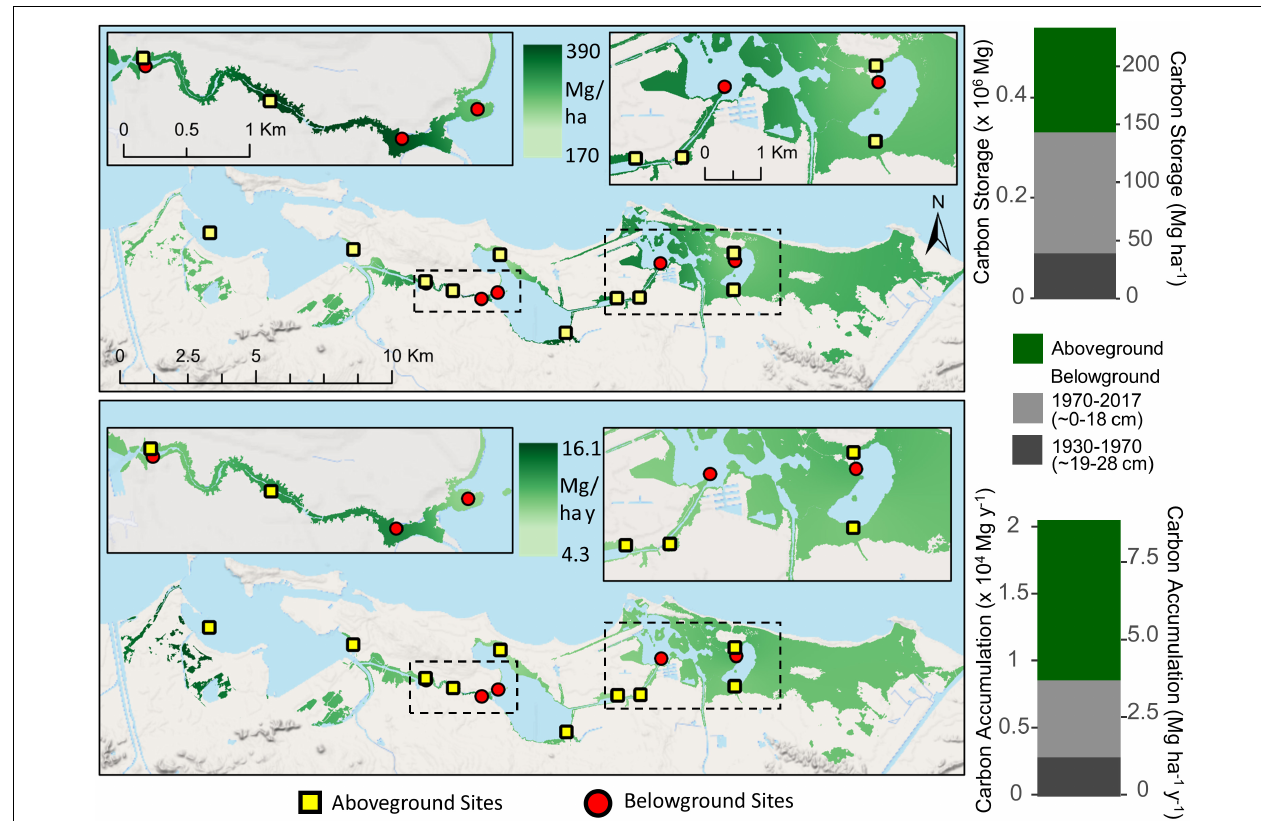
FIGURE 5 | Interpolated mangrove forest carbon storage (top) and accumulation rates (bottom) for both aboveground and belowground soil ( < 28 cm) components in the San Juan Bay Estuary. Map values represent distance weighted interpolations between known measurements at site locations. Bar graphs represent sums of all mangrove areas across the watershed. Aboveground mangrove sites (Branoff and Martinuzzi, 2020) are denoted by squares and belowground sites (this study) by